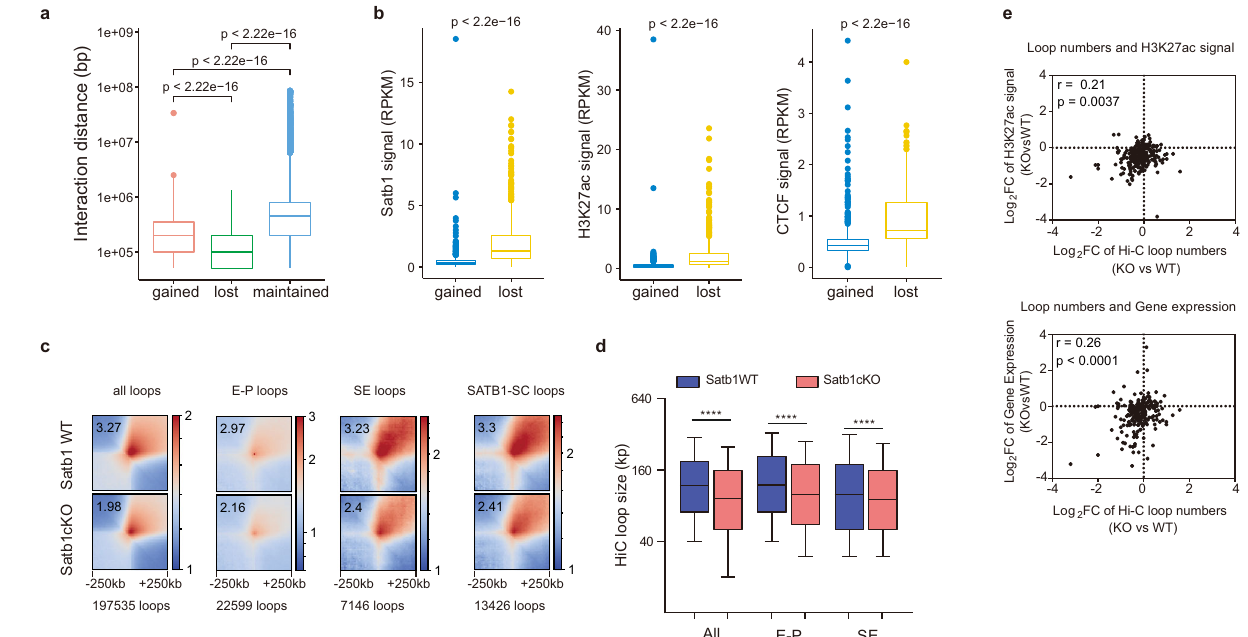
Fig. 4 | SATB1 mediated the chromatin interactions of super-enhancers. a Boxplot showing the contact distance changes between two anchors of sig- ni fi cantly changed contacts (50kb bin) in Satb1-de fi cient DP thymocytes. Gained, signi fi cantly increased interactions; lost, signi fi cantly decreased interactions; maintained, no signi fi cant changed interactions. The interactions with 0bp dis- tance were deleted. (gained, n =500, P =2.2e-16; lost, n =411, P =2.22e-16; main- tained, n =765200, P =2.22e-16).Boxplotsshowmedian(centerline),interquartile range (box), and fi fth and 95th percentiles (whiskers). The one-tailed Wilcoxon signed-rank test was used. b Boxplot of ChIP-seq signals in anchors of differential chromatin interactions (50kb bin). 648 gained SEs and 549 lost SEs, P =2.22e-16. Box plots show median (center line), interquartile range (box), and fi fth and 95th percentiles (whiskers). The one-tailed Wilcoxon signed-rank test was used. c Aggregate interactions of all loops, enhancer – promoter (E-P) loops, super-